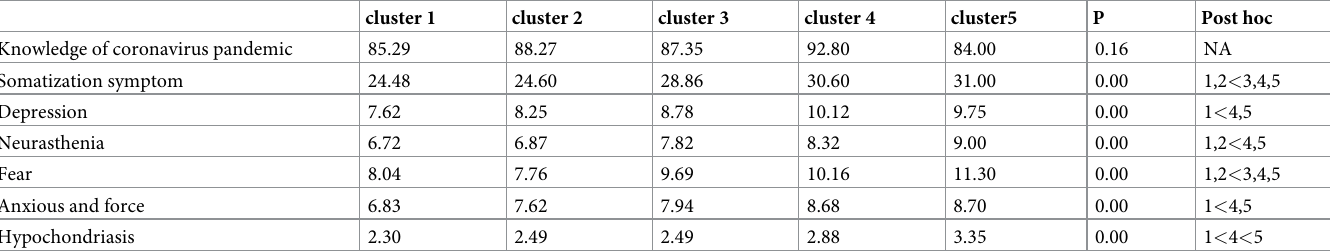
Table 6. MANOVA of the threatened perception types, knowledge of the coronavirus pandemic and mental